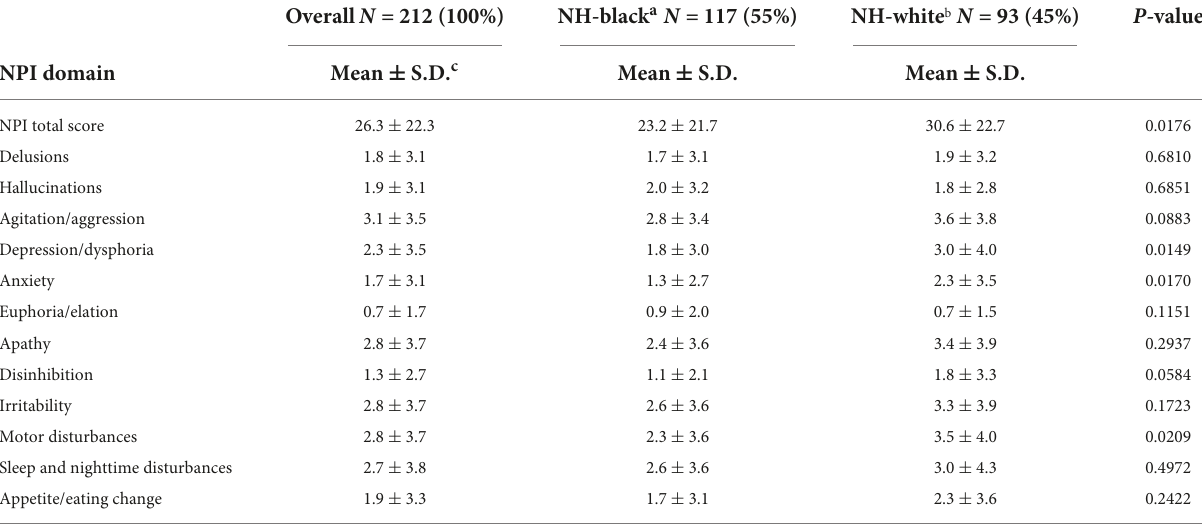
TABLE 2 Mean scores of neuropsychiatric inventory questionnaire a domains in community-dwelling older adults with Alzheimer’s disease living with a caregiver and stratified by race/ethnicity, 2010 ( n = 212). Overall N = 212